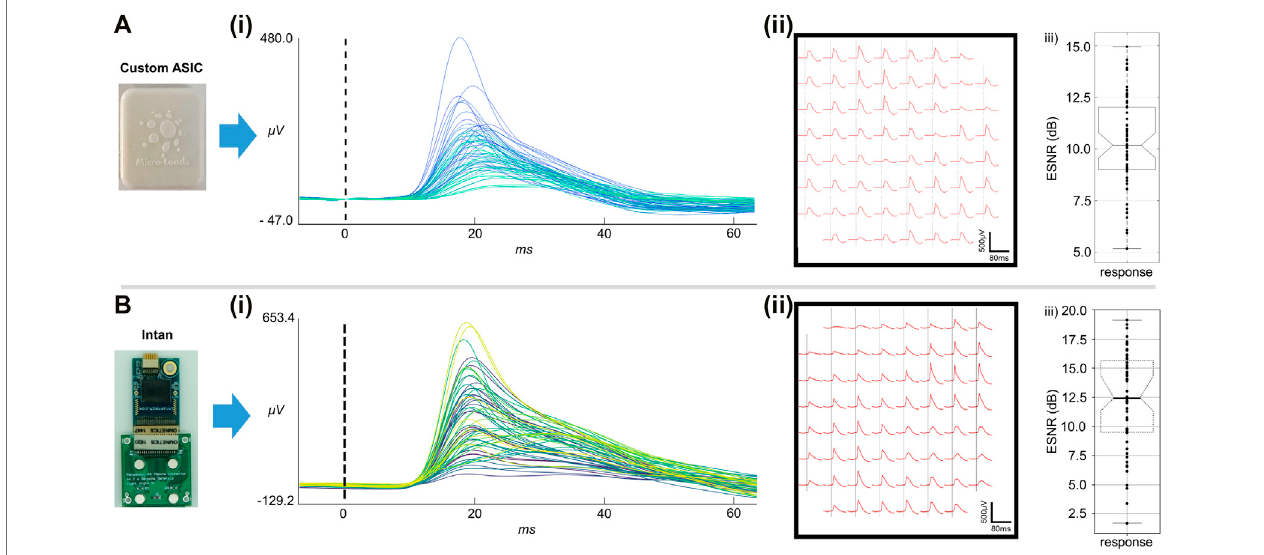
FIGURE6| Acute in-vivo recordings. (A) In-vivo recordingsusinganLCP-substrateelectrodeconnectedtothecustomASICMUX. (i) Averagedevokedresponses from all 61 electrode channels. (ii) Averaged evoked potentials at each electrode site on the 61 channel array. (iii) ESNR for the ASIC MUX recordings. (B) In-vivo recordings using an LCP-substrate electrode connected to conventional recording system (Intan). (i) Averaged evoked responses from all 61 electrode channels. (ii) Averaged evoked potentials at each electrode site on the 61 channel array. (iii) ESNR for the Intan headstage